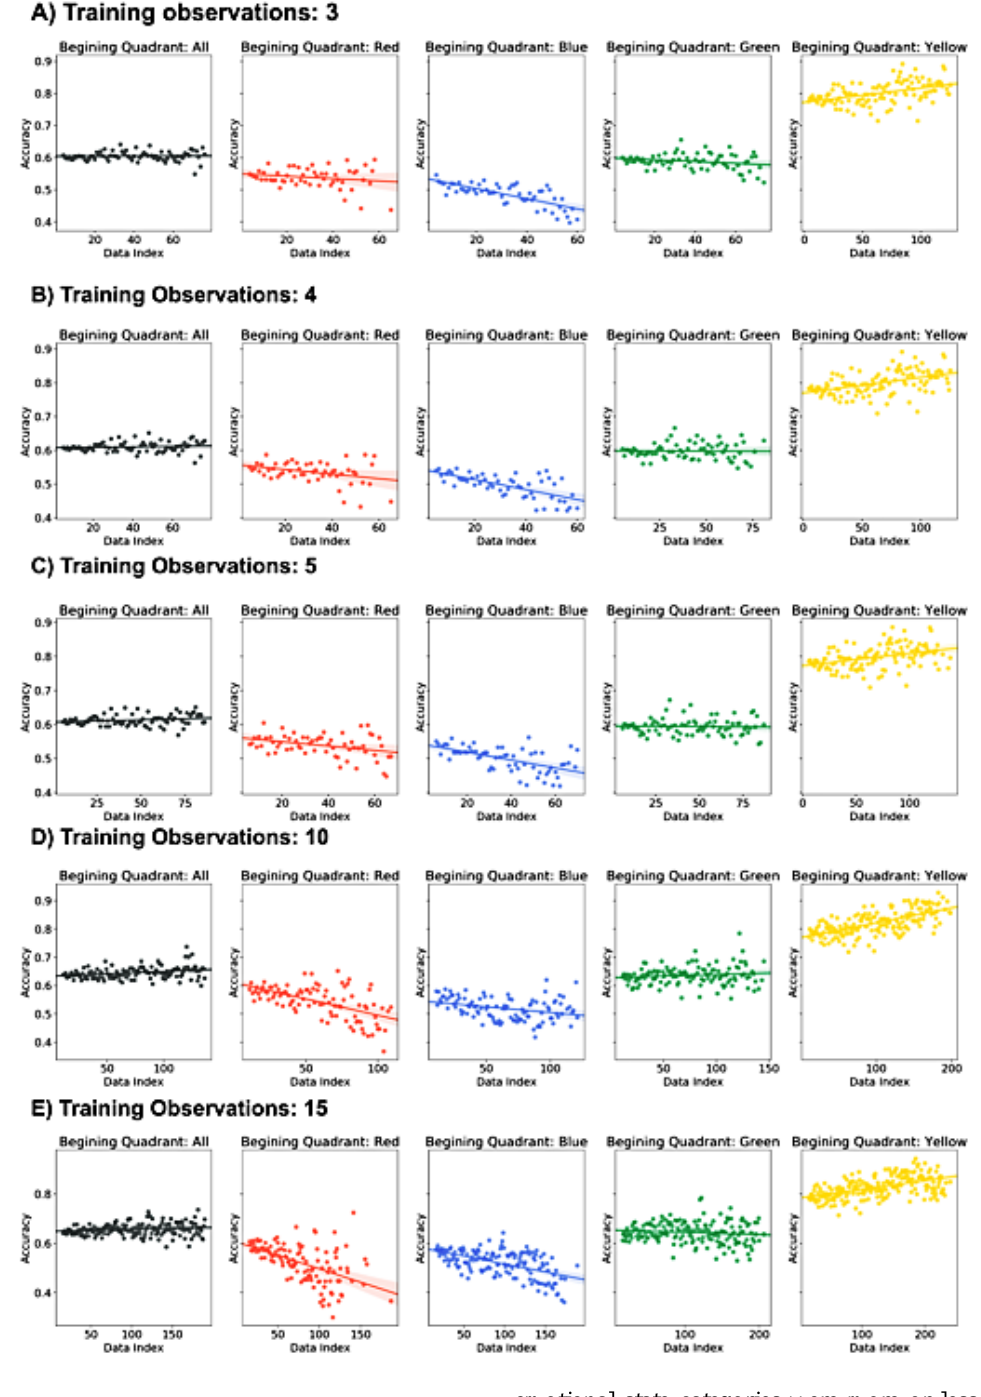
Figure 9. Ending Yale Mood Meter (YMM) quadrant prediction accuracy from distance to training data. Accuracy of models for predicting post-mindfulness and meditation activity (MMA) YMM quadrant emotions with varying number of observations used for training. Accuracy is also shown as a function of the pre-MMA YMM quadrant and suggests differing levels of accuracy and change in accuracy given the pre-MMA